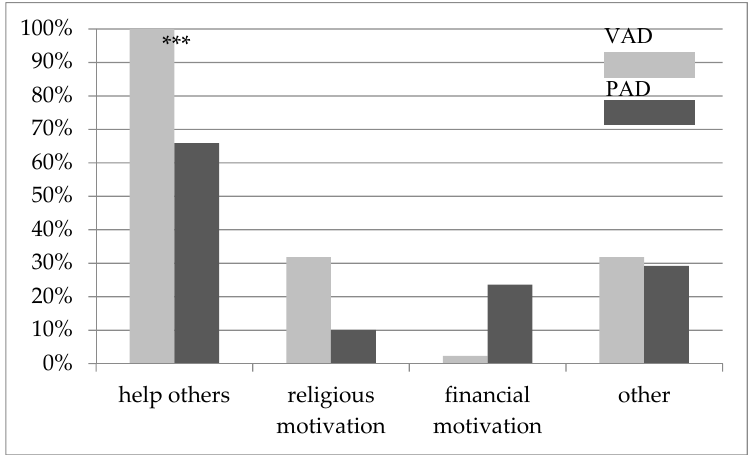
Figure 1. Engagement motivators for refugee work for voluntary aid workers (VAD) and professional aid workers (PAD). Multiple answers possible; others = e.g., this is my job; intercultural interest; *** p <